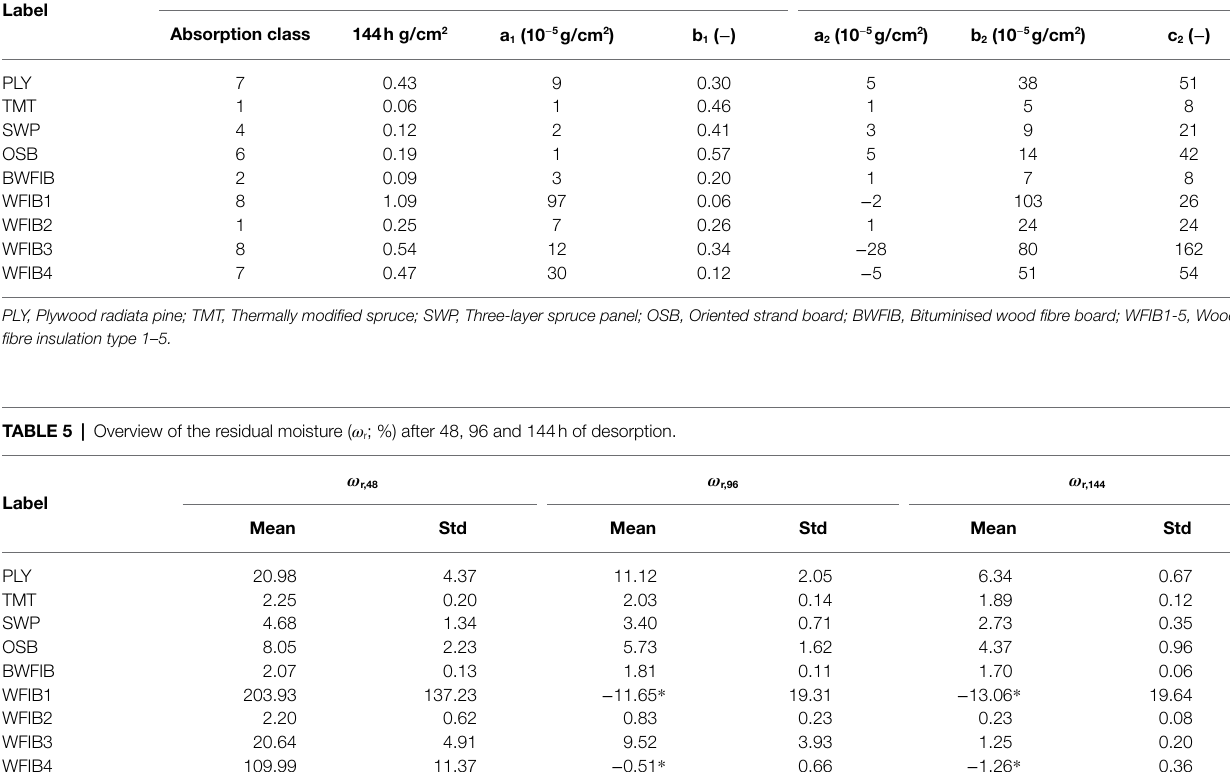
TABLE 4 | Absorption class, water uptake (g/cm 2 ) at 144 h of absorption and parameters of fitted curves for absorption and desorption phases. Absorption Eq. (3) Label